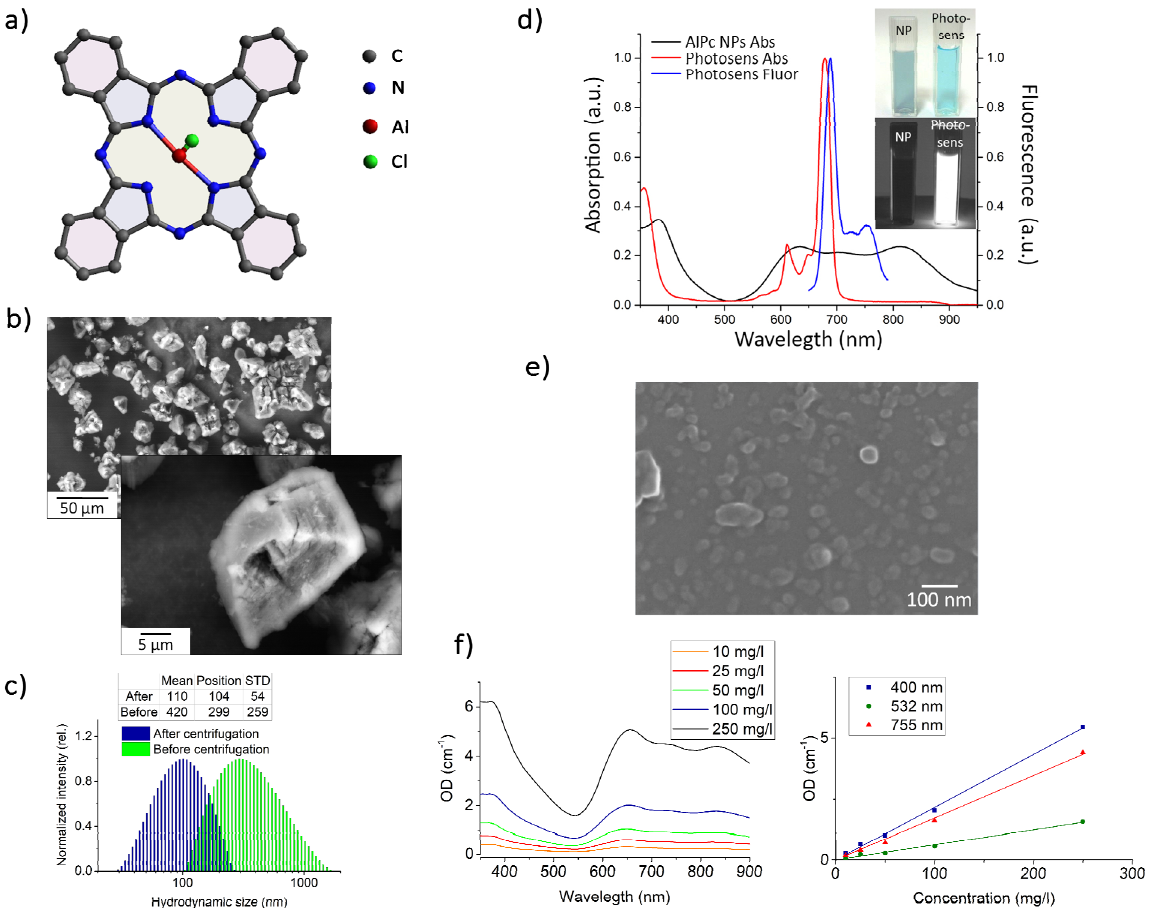
Figure 1. ( a ) Aluminum phthalocyanine chloride (AlPcCl) used in the study; ( b ) SEM images of AlPc microparticles; ( c ) size distribution of the obtained particles in the colloid before and after centrifugation; ( d ) absorption spectra of Photosens and of crystalline AlPc NP colloids and the fluorescence spectrum of Photosens, as well as their visible and fluorescent images at 400 nm excitation (inset) ( e ) SEM images of obtained AlPc NPs; ( f ) absorption spectra for various concentrations of AlPc NP colloids: 10–250 mg/L (left), calibration curves for determining the concentration of AlPc NP colloids (right) by OD.